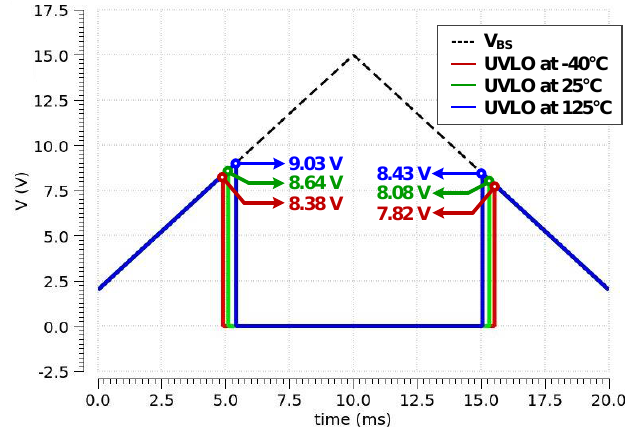
Figure 6. Proposed under-voltage lockout (UVLO) operation at different temperatures.